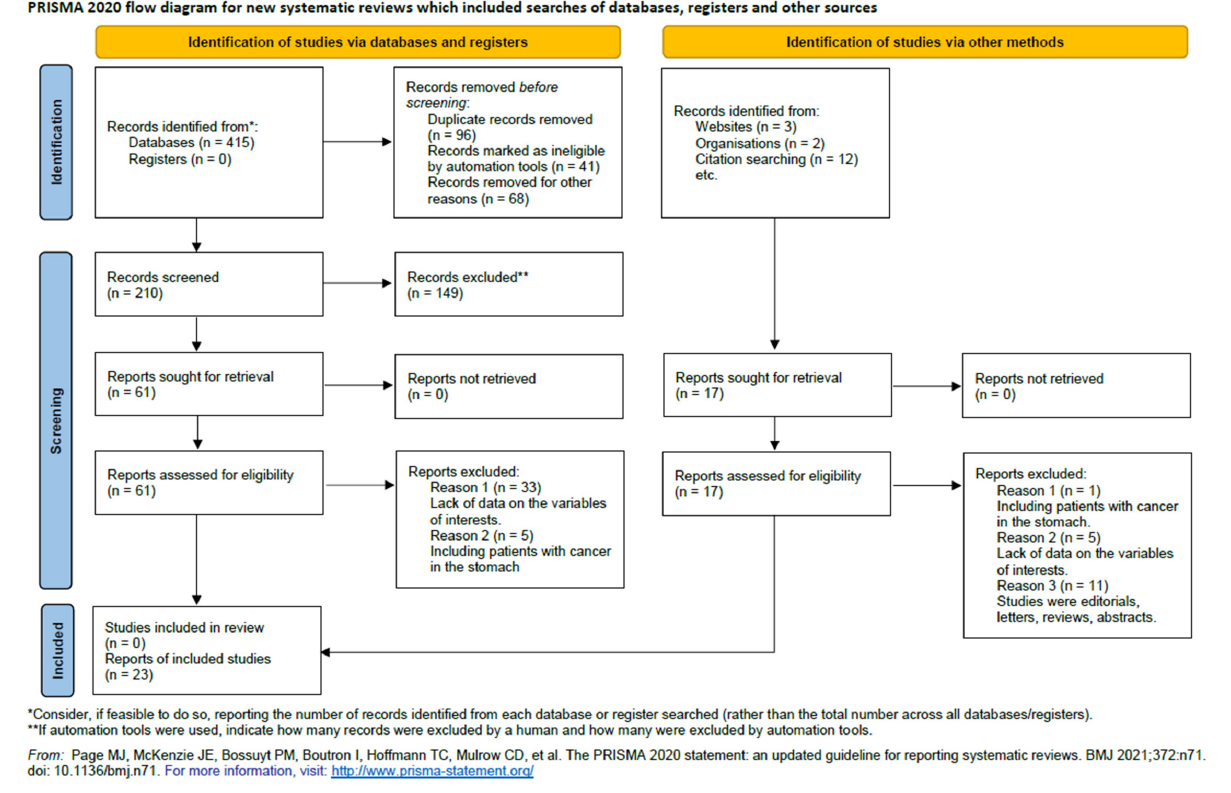
FIGURE 1 | Flowchart of the studies selection